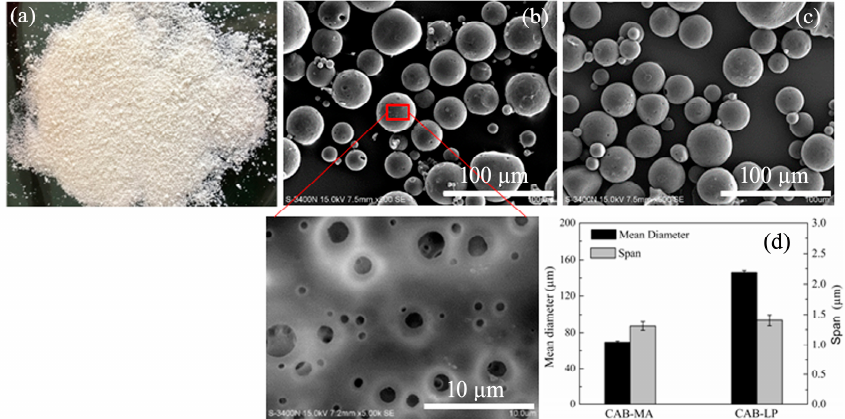
Figure 6. The photograph of the CAB microspheres containing emamectin benzoate (EB/CAB) ( a ); the SEM mages of microspheres prepared by CAB-MA ( b ) and CAB-LP ( c ), respectively; the mean diameter of EB/CAB-MA and EB/CAB-LP ( d ).